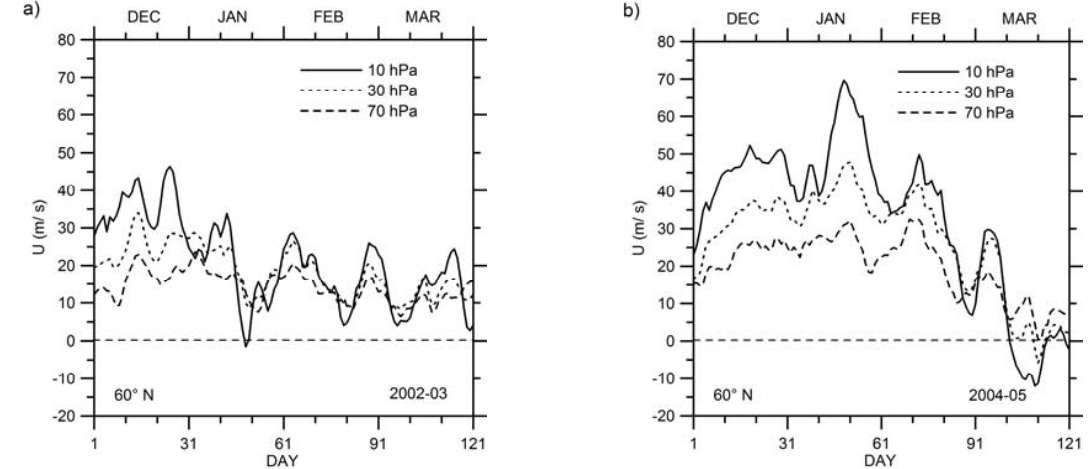
Fig. 3. Zonal mean zonal wind (ms − 1 ) at 60 ◦ N at 70, 30 and 10hPa from 1 December to 31 March (a) winter 2002–2003 and (b) winter 2004–2005.